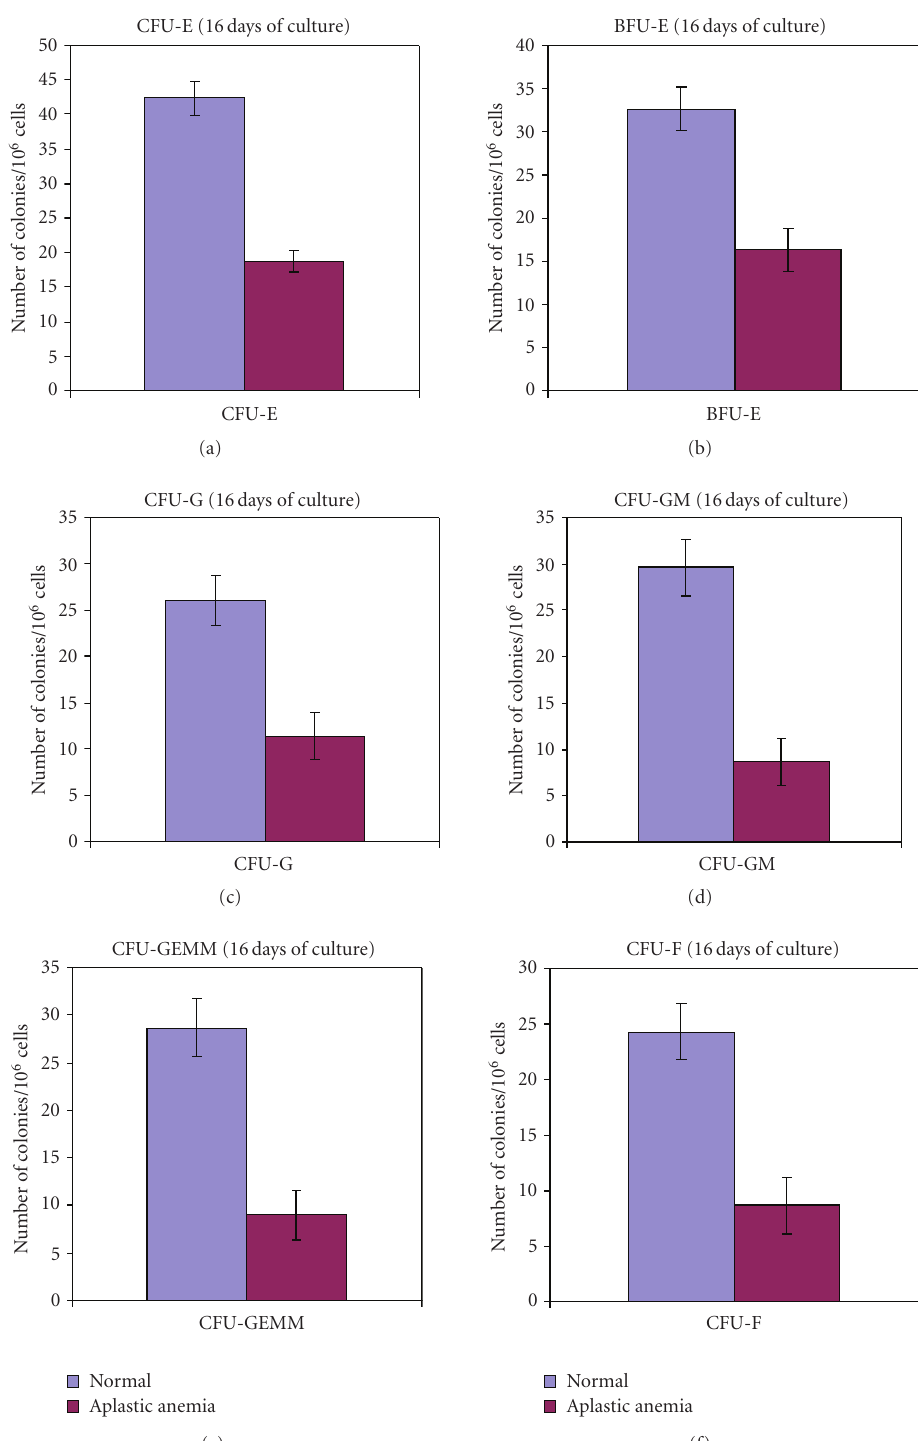
Figure 4: Colony forming e ffi ciency of the bone marrow-derived cells from the normal and aplastic anemic groups of mice. (a) Colony forming unit erythrocytes (CFU-E) from the normal and aplastic bone marrow cells. (b) Erythroid burst forming unit (BFU-E) in normal and AA. (c) Colony forming unit granulocytes (CFU-G) by the AA and normal bone marrow cells. (d) Colony forming unit granulocytes macrophages (CFU-GM) from the AA and normal bone marrow cells. (e) Colony forming unit granulocyte erythrocyte monocyte macrophage (CFU-GEMM) in normal and AA. (f) Colony forming unit fibroblasts form the normal and AA bone marrow cells. All the results represent the relative number of CFUs in aplastic anemia as compared to the normal and correspond to the median ± S.D. levels observed from 15 ( n = 15) samples studied ( P < .